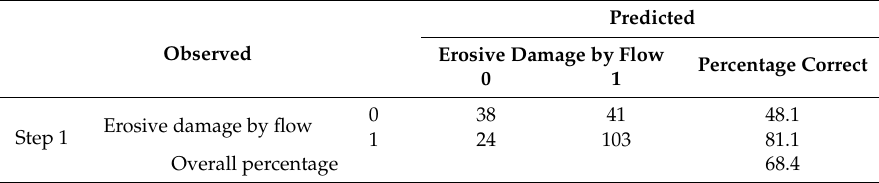
Table 5. Goodness-of-fit results for erosive damage caused by surface flows.